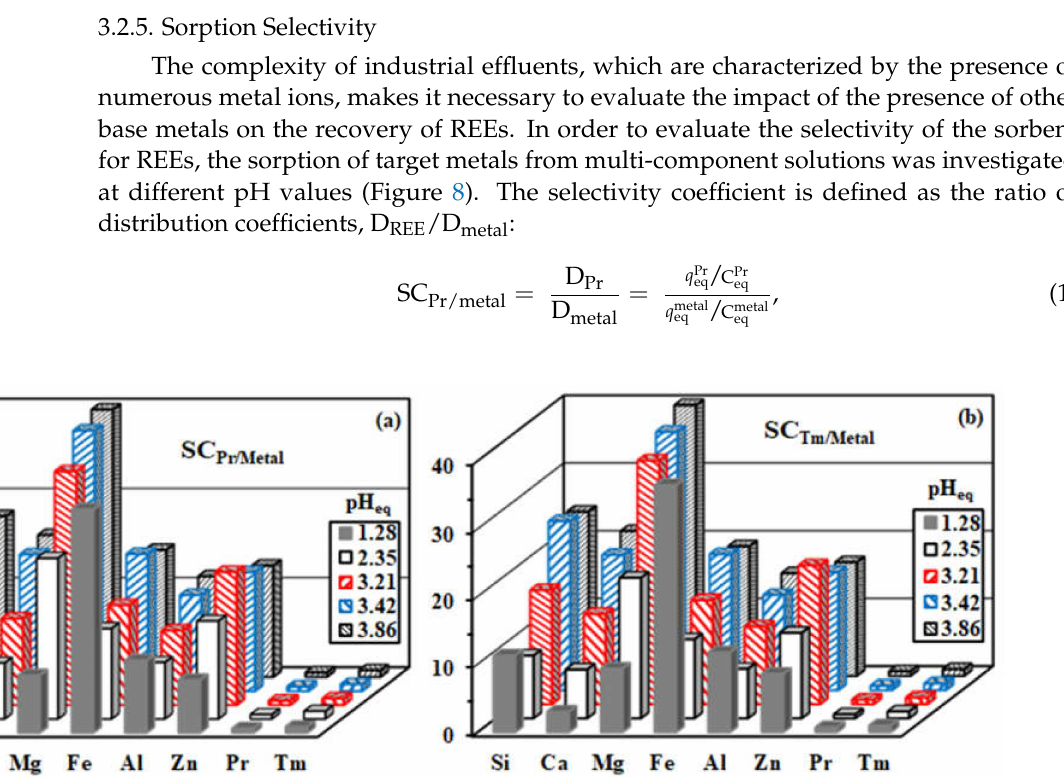
Figure 8. Effect of pH eq on the selectivity coefficients of P2-APEI for Pr(III) ( a ) and Tm(III) ( b ) against other base metals and alkali-earth metals (equimolar 1 mM solutions; SD: 0.5 g L − 1 ; contact time: 48 h; T: 22 ± 1 ◦